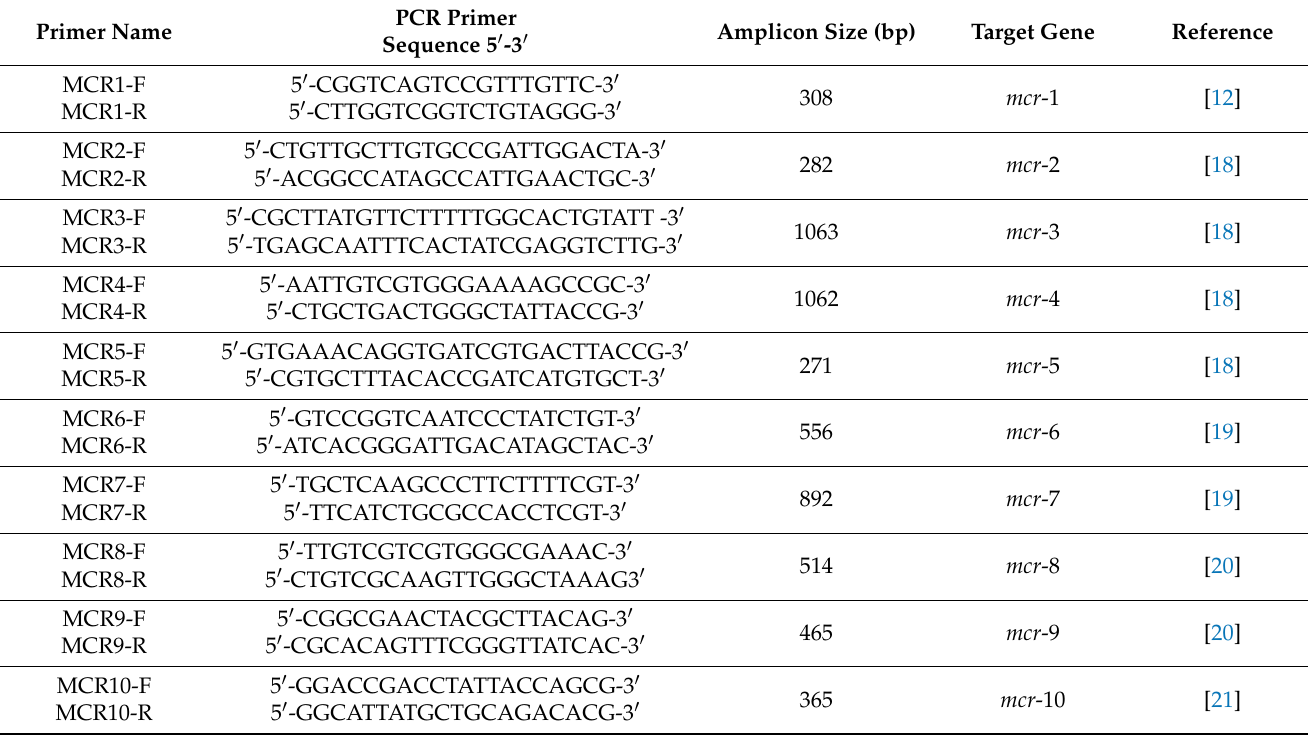
Table 1. PCR primers used in this